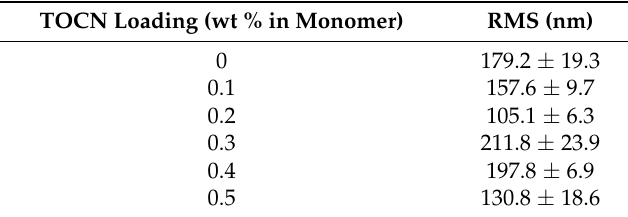
Table A2. Numerical RMS roughness values for membranes fabricated with TOCNs via the dispersion